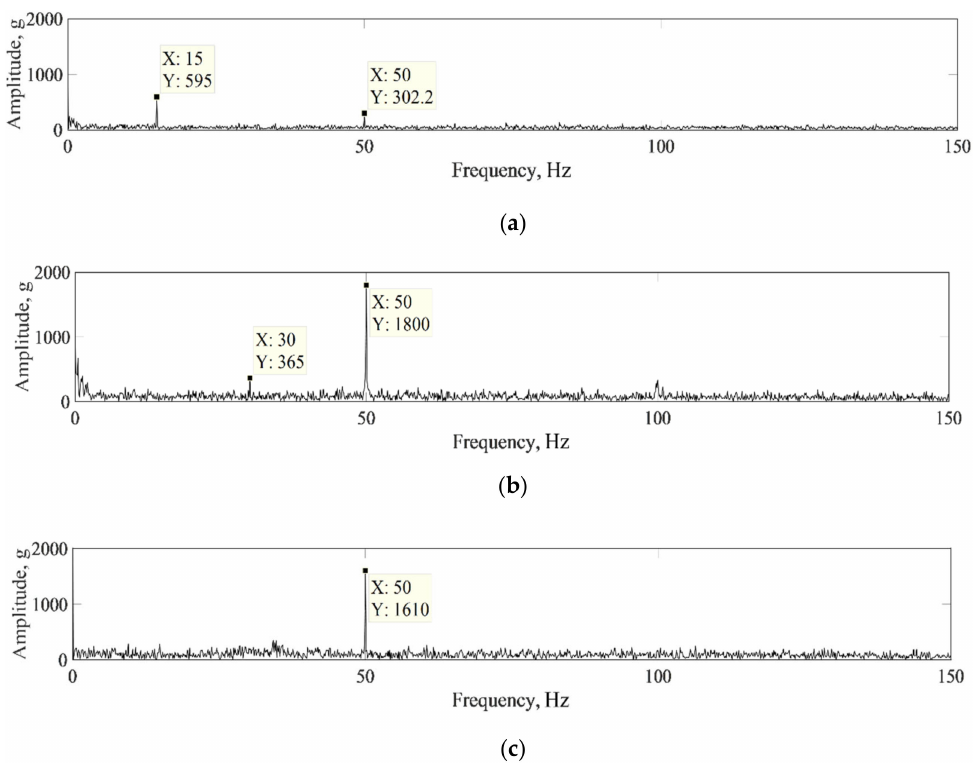
Figure 2. Average frequency domain distribution of four sensors installed in di ff erent horizontal planes: ( a ) z = − 100 mm ( b ) z = − 200 mm and ( c ) z = − 300